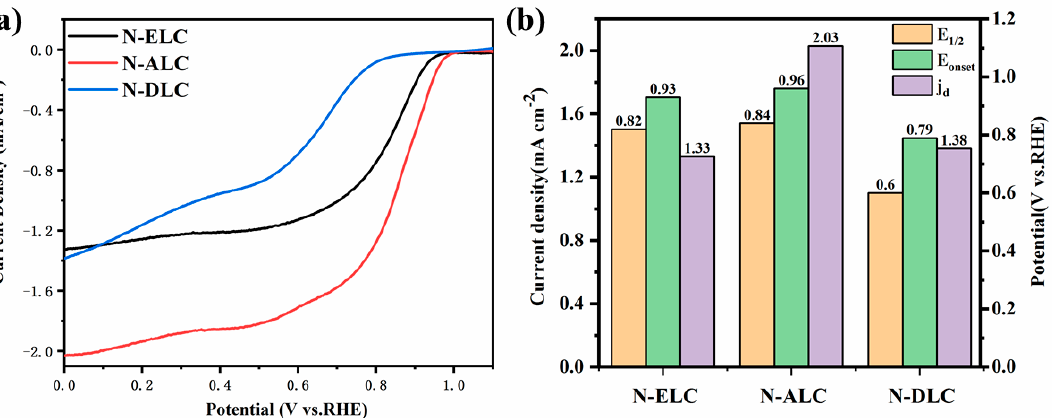
Figure 9. ORR performance: ( a ) LSV curve obtained at 1600 rpm. ( b ) Performance comparison bar chart